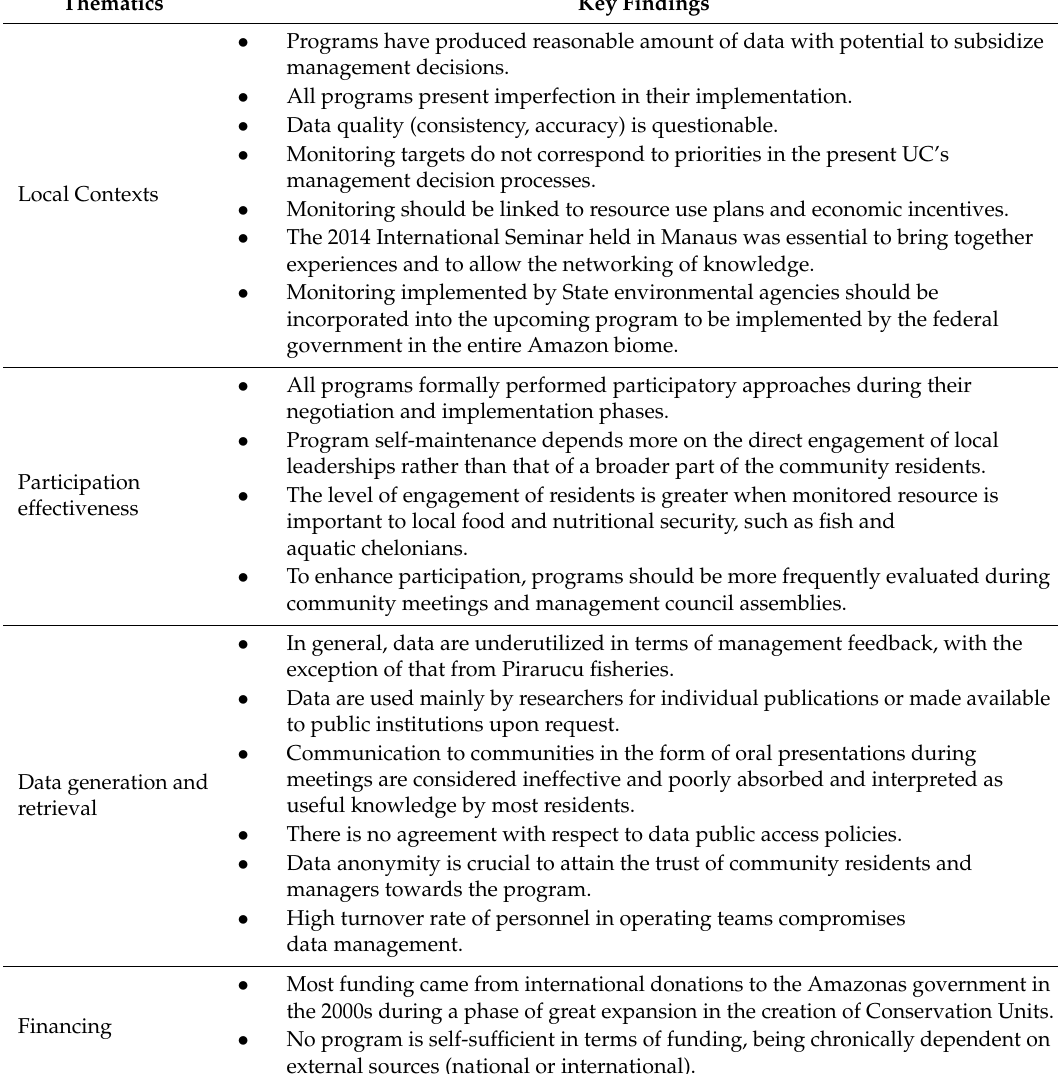
Key findings of participatory qualitative assessment of the four PCM programs